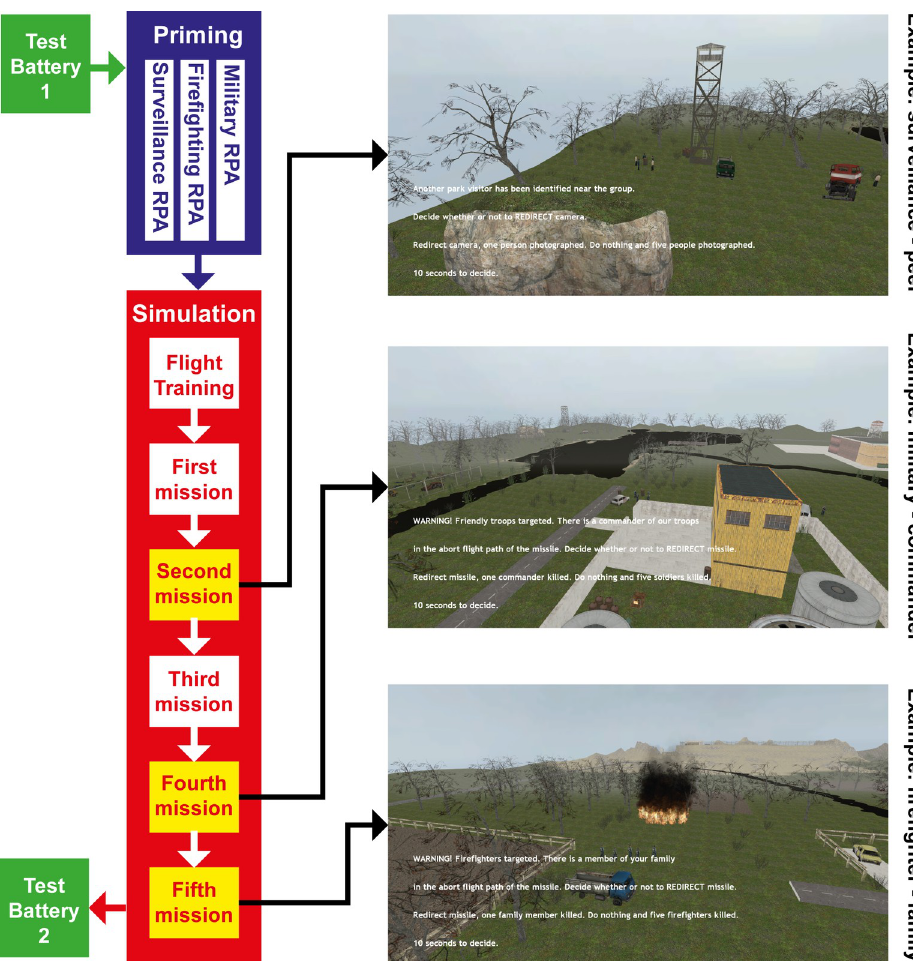
Fig 1. Outline of the RPA simulation. Left side: Experiment’s design. Right side: RPA simulation. Top: First choice– five versus one peer (surveillance; control condition). Middle: Second choice–soldiers vs. commander (military context). Bottom: Third choice–firefighters vs. family member (firefighter condition).